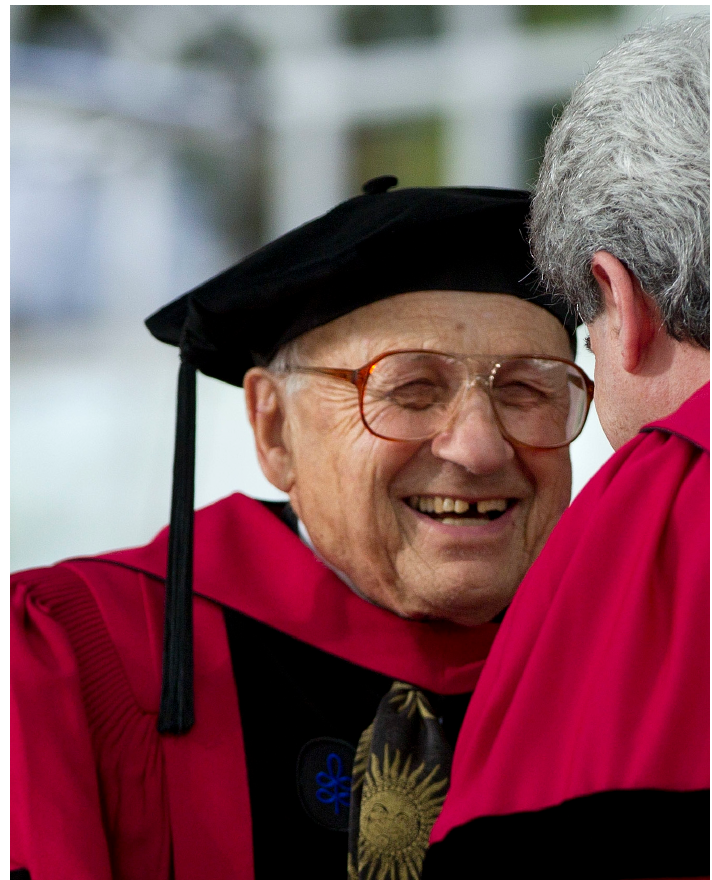
Figure 1. Walter Kohn was presented receiving an honorary Doctor of Science degree by the Harvard University (AP Photo/Steven Senne).